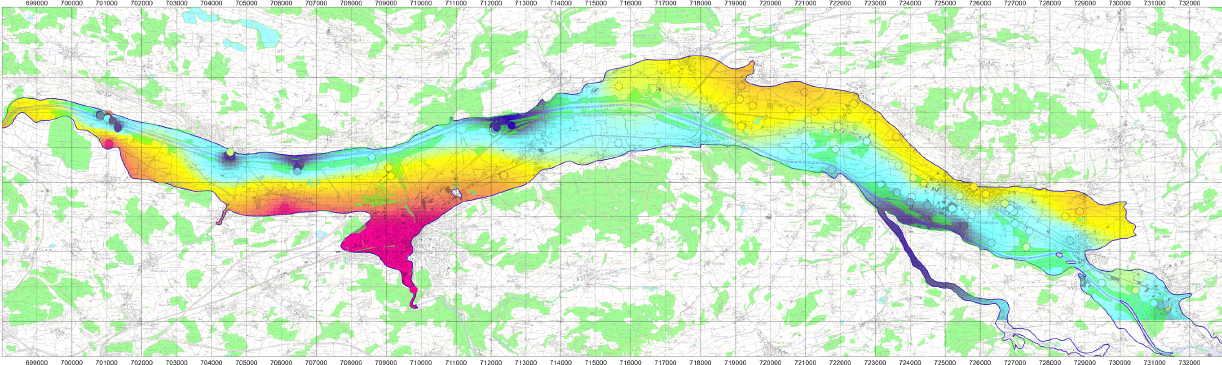
Table 1. Average concentrations of chemical water constituents in water of River Thur, in alluvial groundwater of wells located at dis- tances of > 300m and < 300m from the banks of River Thur, and in groundwater from valley slopes, and numbers of respective sam- pling stations. < 300m > 300m from distance distance valley to to Thur